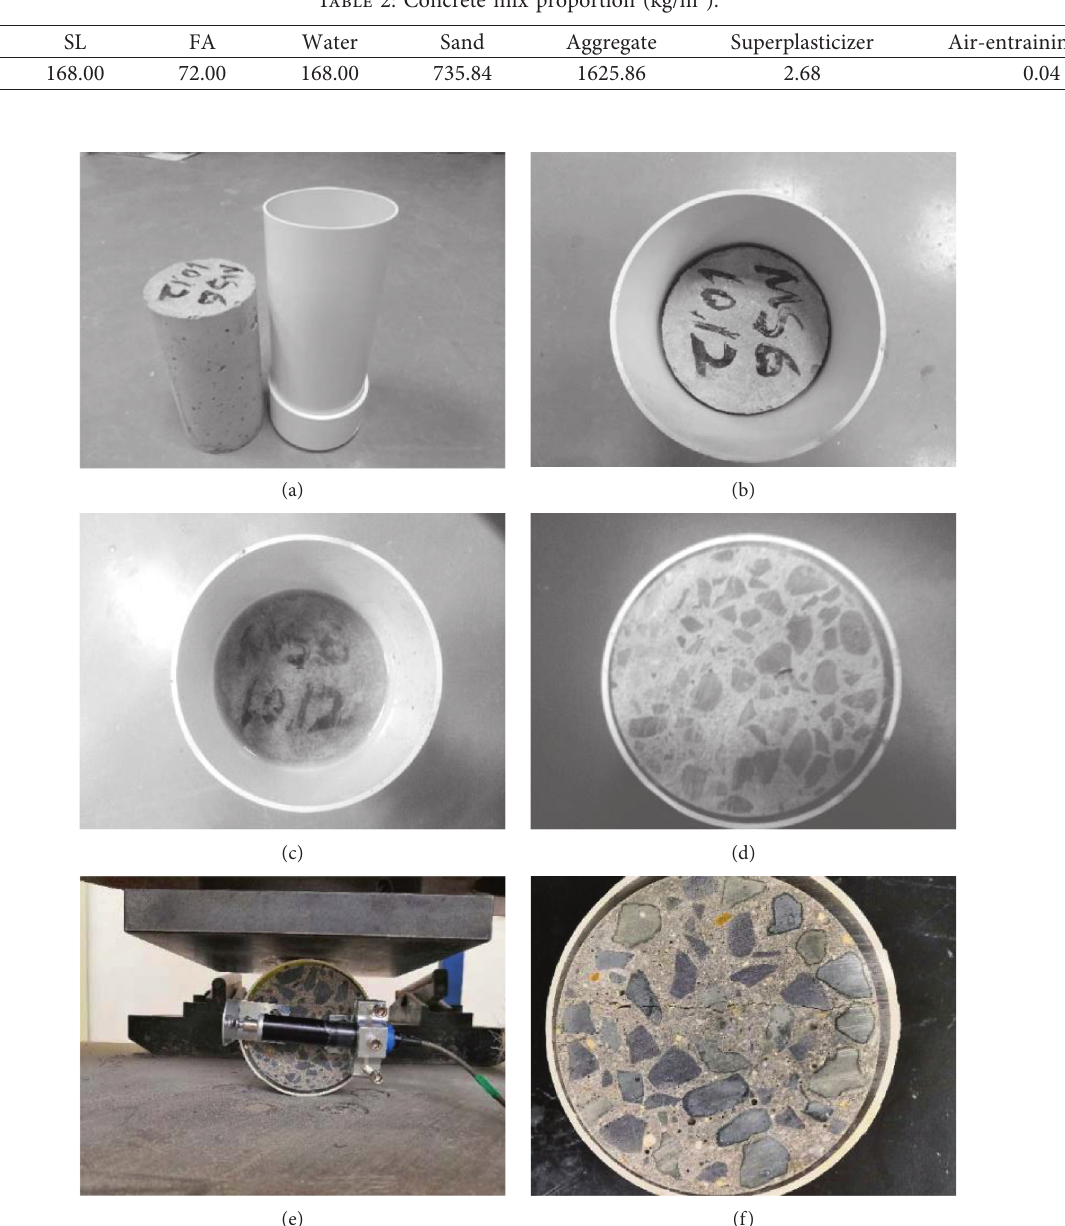
Figure 1: Preparation process of cracks in concrete specimens.